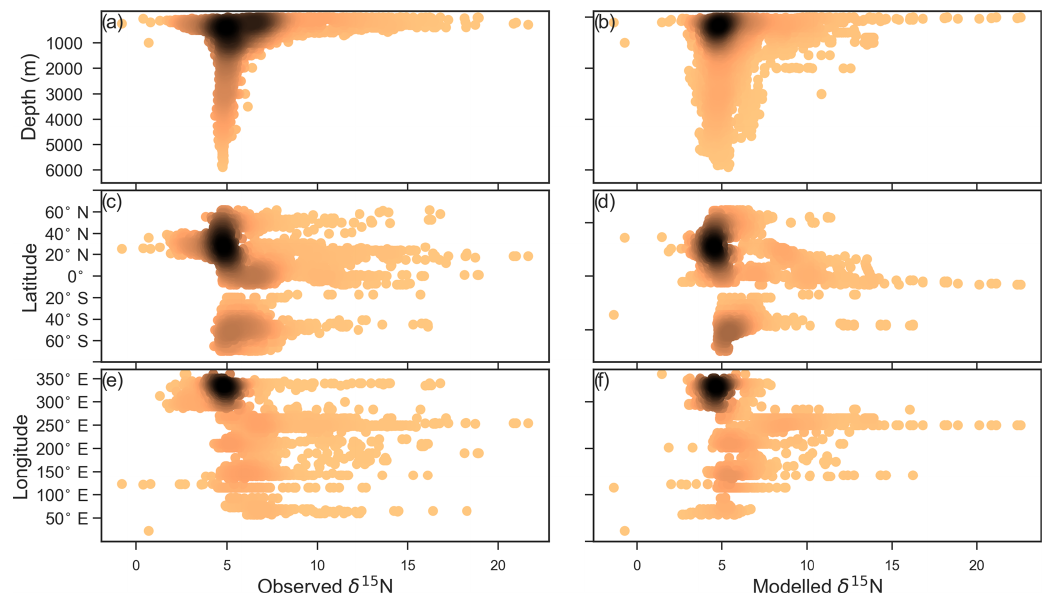
Figure 7. Observed (a, c, e) and modelled (b, d, f) δ 15 N of NO 3 data ( N = 5004) plotted against depth (a, b) , latitude (c, d) and longitude (e, f) . Colour shading represents the density of data, such that the darker a mass of data points is, the more data are represented there.